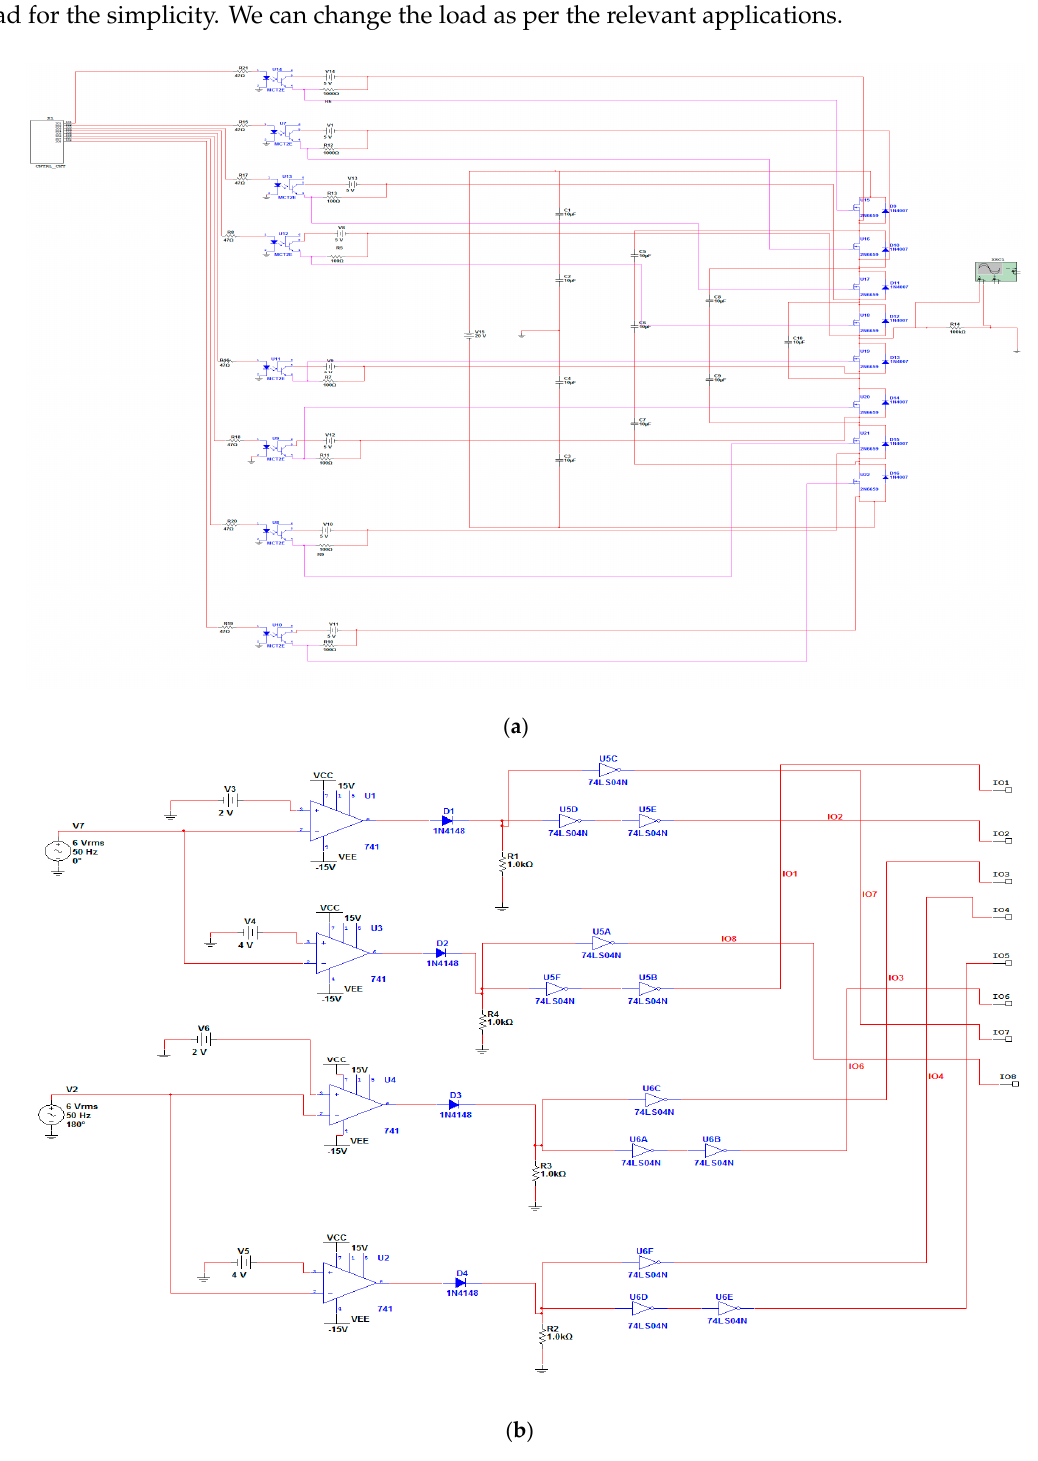
Figure 14. ( a ). Power circuit of 5-Level FC-MLI MULTISIM simulations; ( b ) control circuit of 5-Level FC-MLI MULTISIM simulations.